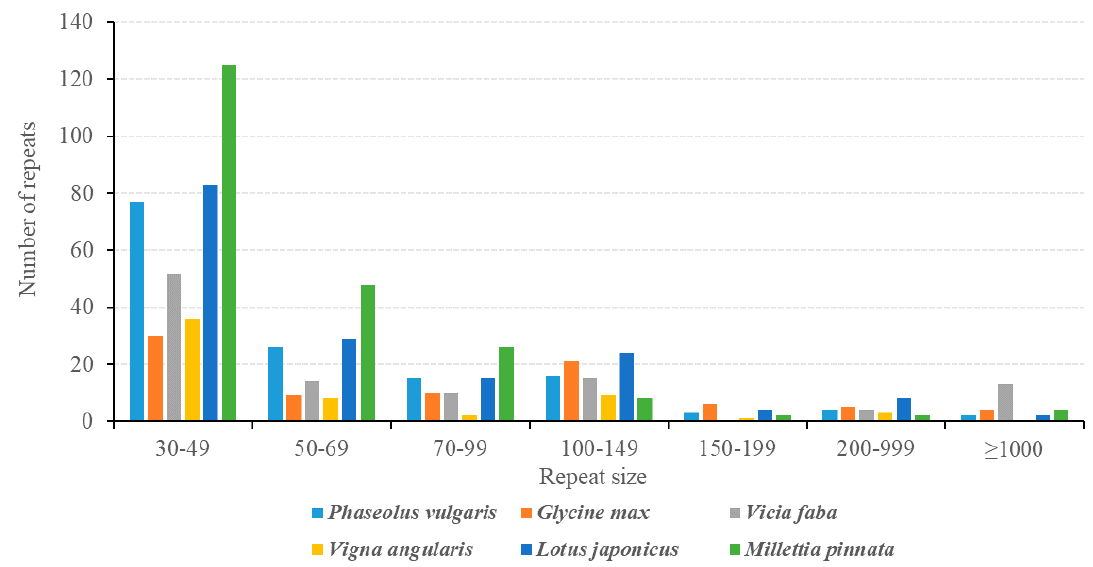
Figure 7. Frequency distribution of dispersed repeat in the P. vulgaris mitogenome compared with five other leguminous plants. The number of dispersed repeats in Phaseolus vulgaris , Glycine max Vicia faba , Vigna angularis , Lotus japonicus , and Millettia pinnata mitogenomes are shown by blue, orange, gray, yellow, blue, and green, respectively.